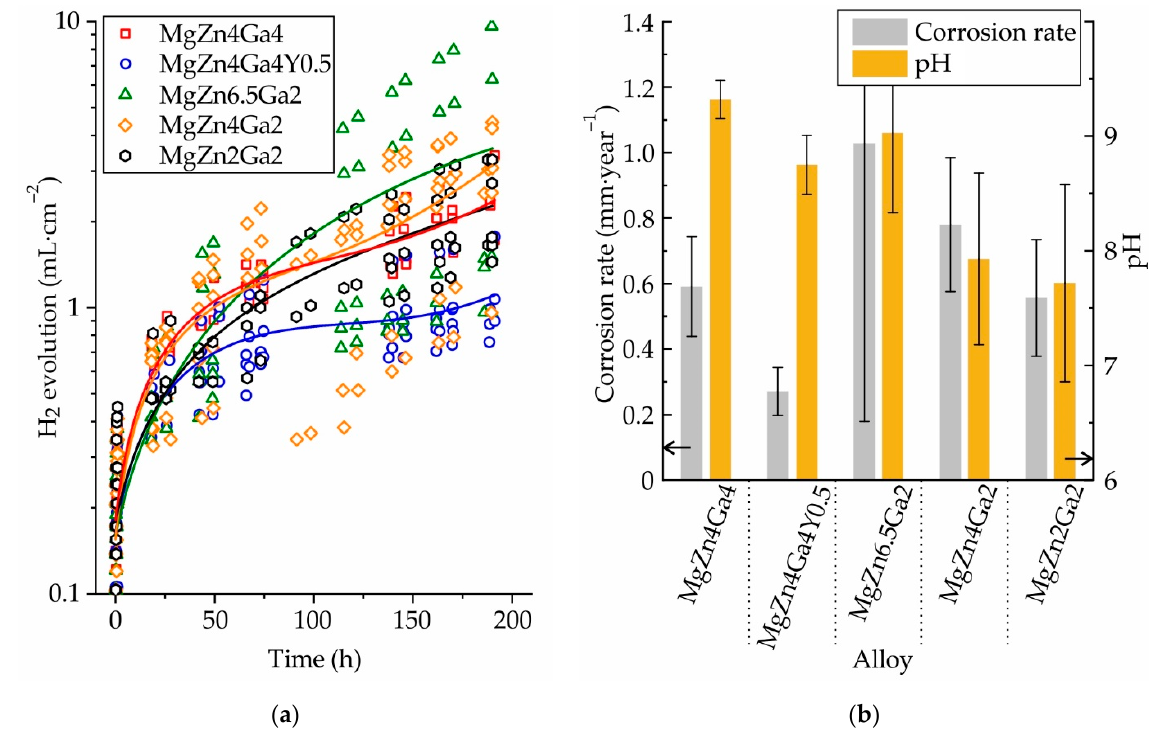
Figure 11. ( a ) H 2 evolution of the T4 heat-treated Mg–Zn–Ga alloys immersed in Hanks’ solution at 37 °C for 192 h. ( b ) Calculated CRs of the alloys and pH variation of the medium during the immersion corrosion testing.